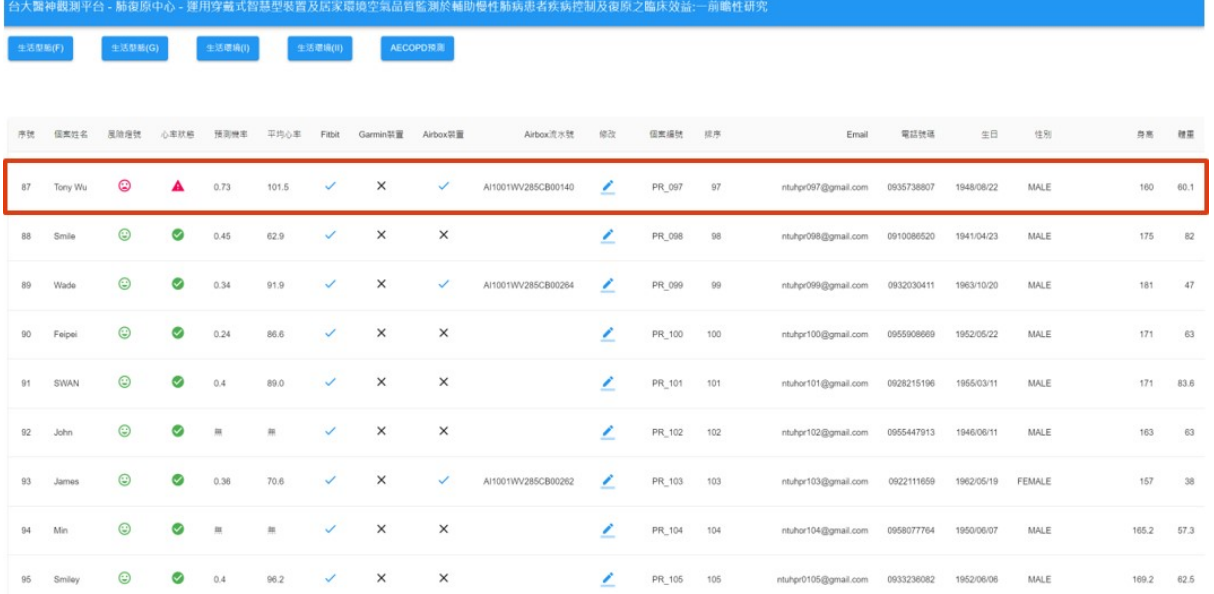
Figure 3. Daily prediction of acute exacerbation of chronic obstructive pulmonary